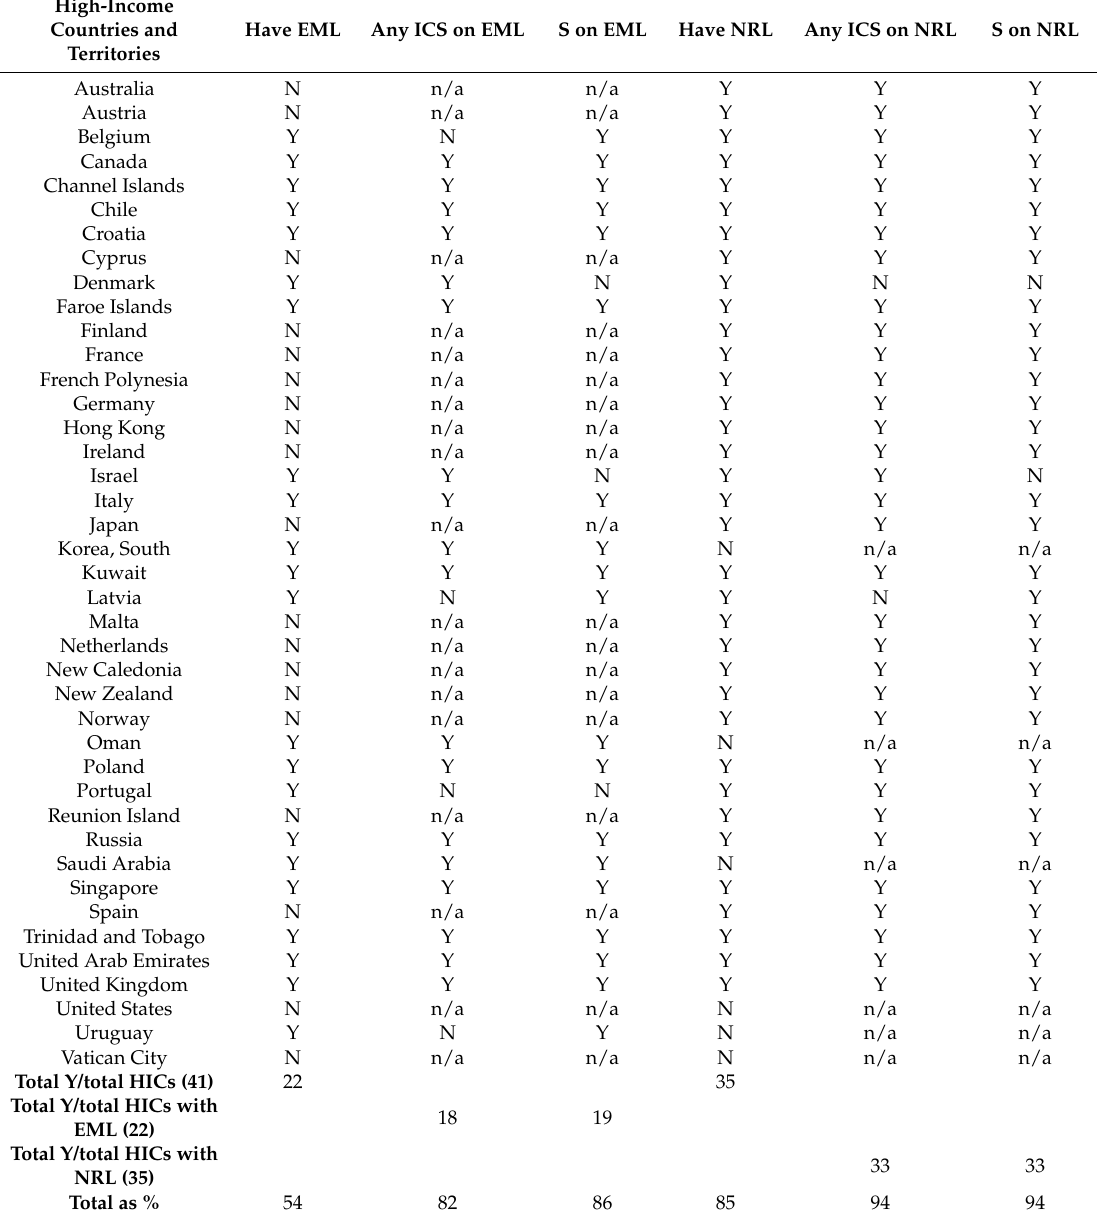
Table 1. Existence of National Medicine List and National Reimbursement List and inclusion of any inhaled corticosteroid and salbutamol, 41 high-income countries and territories, 2014 *. High-Income Countries